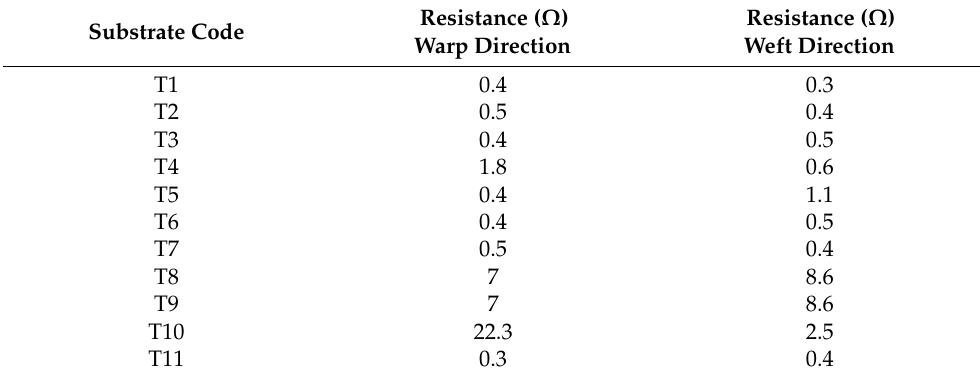
Table 5. Electrical resistance of the printings. Measurements have been made both in warp and weft